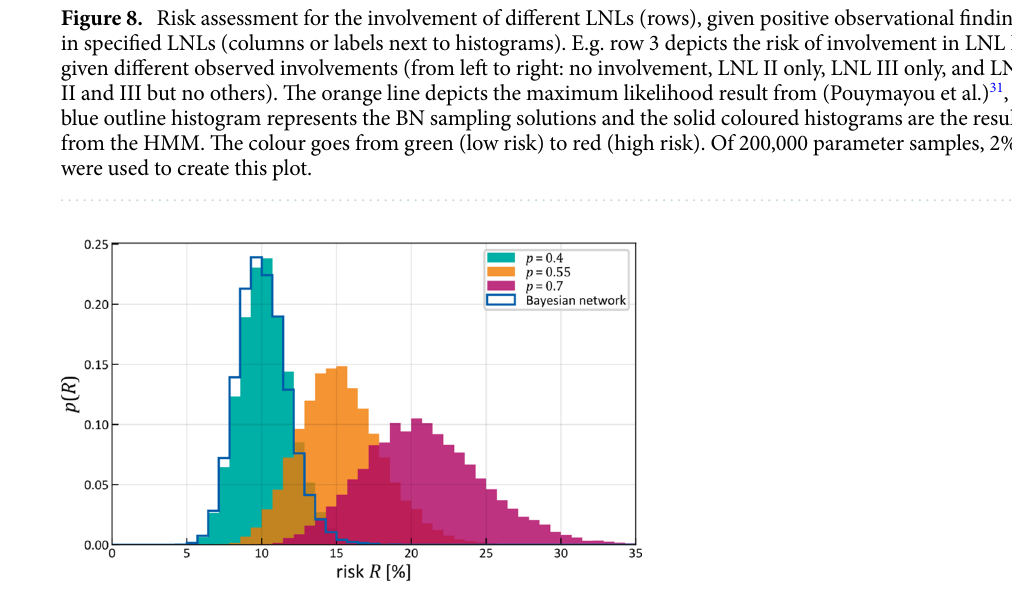
Figure 9. Risk prediction for LNL III, given observed positive involvement in LNL II and negative observations in all other LNLs (assuming s N = 81% and s P = 76% ) 35 . The Binomial parameter p was fixed to 0.4 for parameter learning (green), representing early T-category patients. Increasing this parameter results in higher risk. The blue outline shows the risk in level III obtained for the Bayesian network model. The histograms correspond to 1% of the 200,000